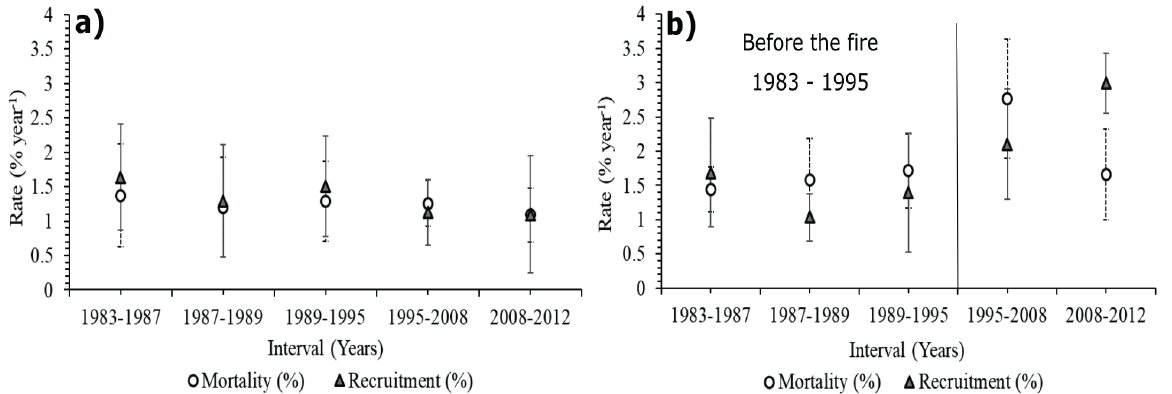
Figure 3 - Annual mortality and recruitment rates - percentage of recruited or killed trees compared to alive trees in the previous measurement, plus the respective standard deviation, for trees ≥ 5 cm DBH, in the T0 plots (1.75 ha), in a , and in the T1 plots (1.25 ha), in b , during 29 years of monitoring, in an dense ombrophylous forest, with no history of logging, in the Floresta Nacional do Tapajós, Pará State,